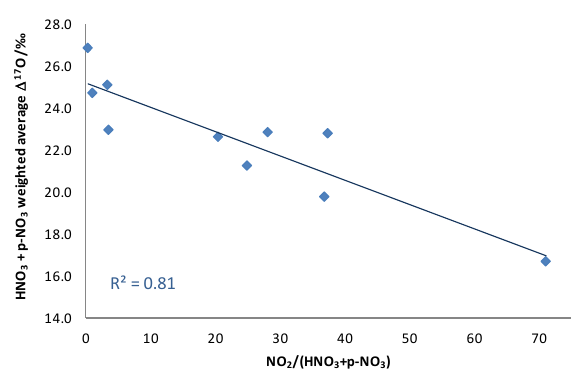
Figure 5. Weighted (cid:49) 17 O average for the sum of dry nitrates as a function of NO 2 concentration divided by p NO 3 plus HNO 3 con- centrations, a ratio indicative of the maturity of a